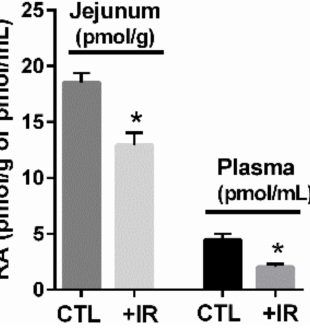
Figure 2. GI mucosal damage results in loss of small intestine RA, which is reflected in reduced plasma RA levels . Loss of gut RA (jejunum, left) resulted in reduced plasma RA levels (right) in a partial body irradiation (PBI) with 5% bone marrow sparing (BM5) non-human primate (NHP) model of radiation-induced gut damage (rhesus macaques; 11.5 Gy PBI/BM5, n = 10; control, n = 10) as quantified by liquid chromatography-tandem mass spectrometry (LC-MS/MS); mean ± SEM (* p < 0.05). Adapted from Yu J, Huang W et al., 2021